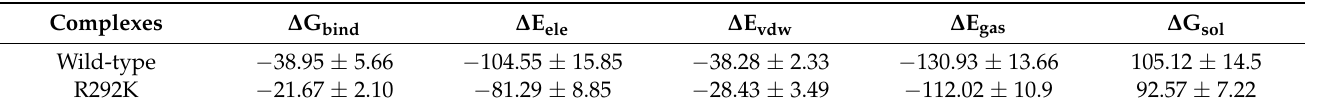
Table 1. MM/GBSA binding free energies profile of peramivir bound to H7N9 wild-type neuraminidase and R292K mutant neuraminidase.